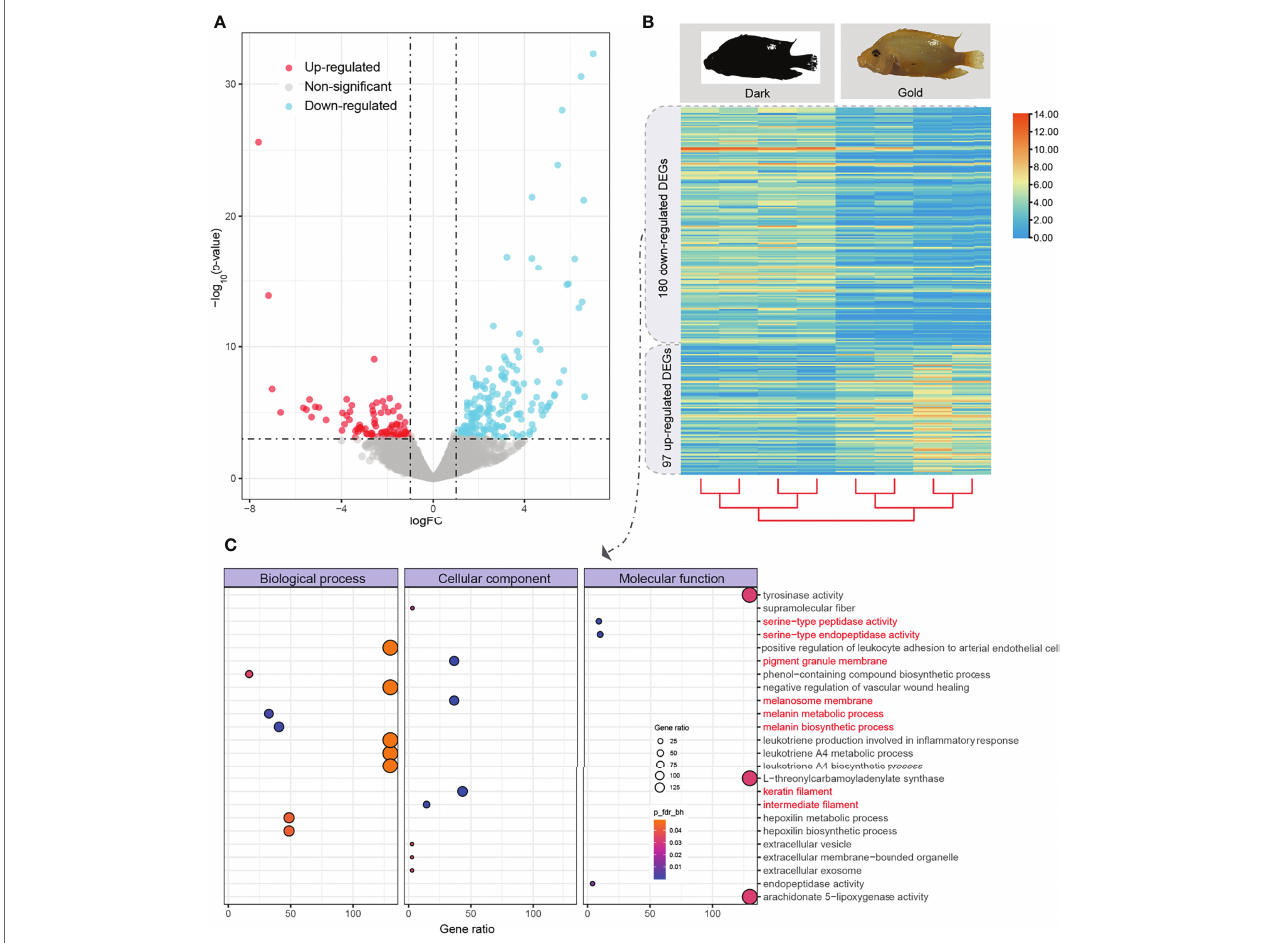
FIGURE 3 | Identification of differentially expressed genes (DEGs) and enrichment of downregulated genes between dark and gold morphs. (A) A volcano plot of up- and downregulated genes (represented by red and blue dots, respectively); (B) A heatmap of transcriptional comparison between dark- and gold-morph individuals; (C) GO enrichment of downregulated